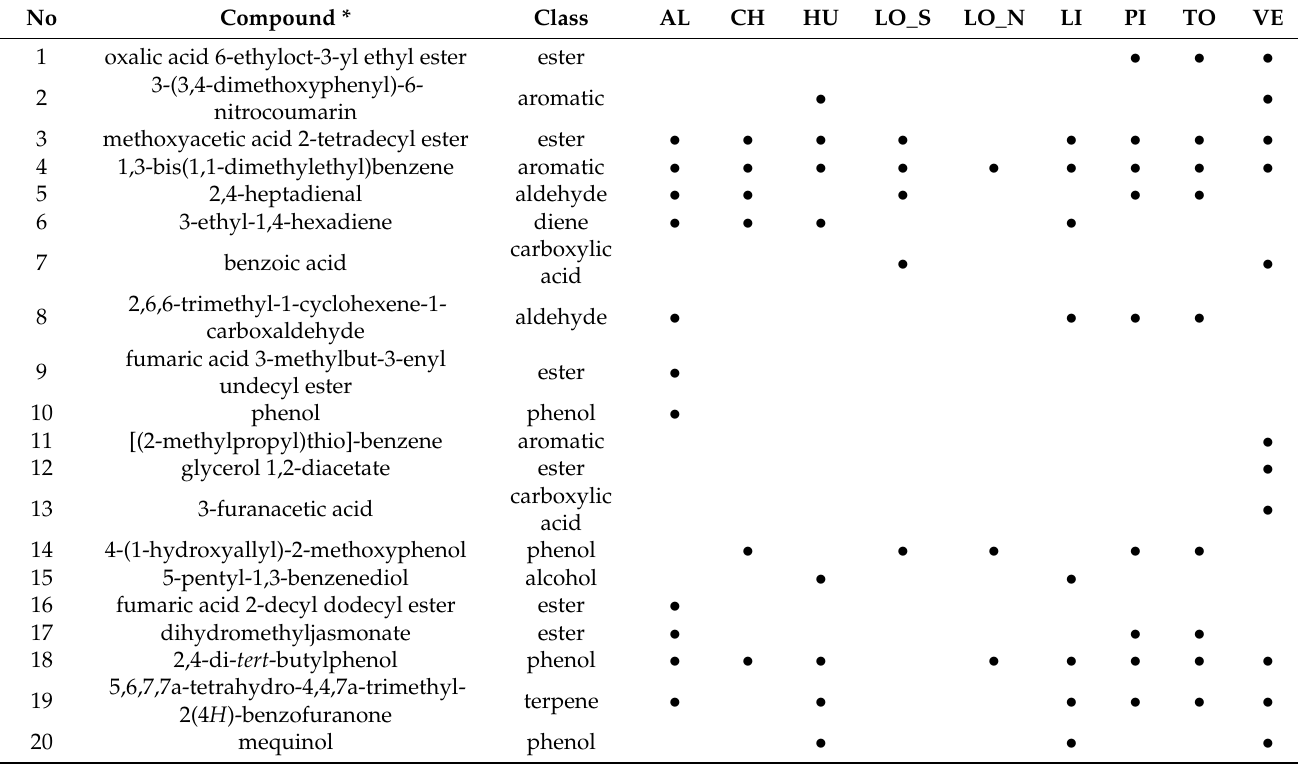
Table 4. Selected quality markers. Symbol “ • ” means that compound was present in a